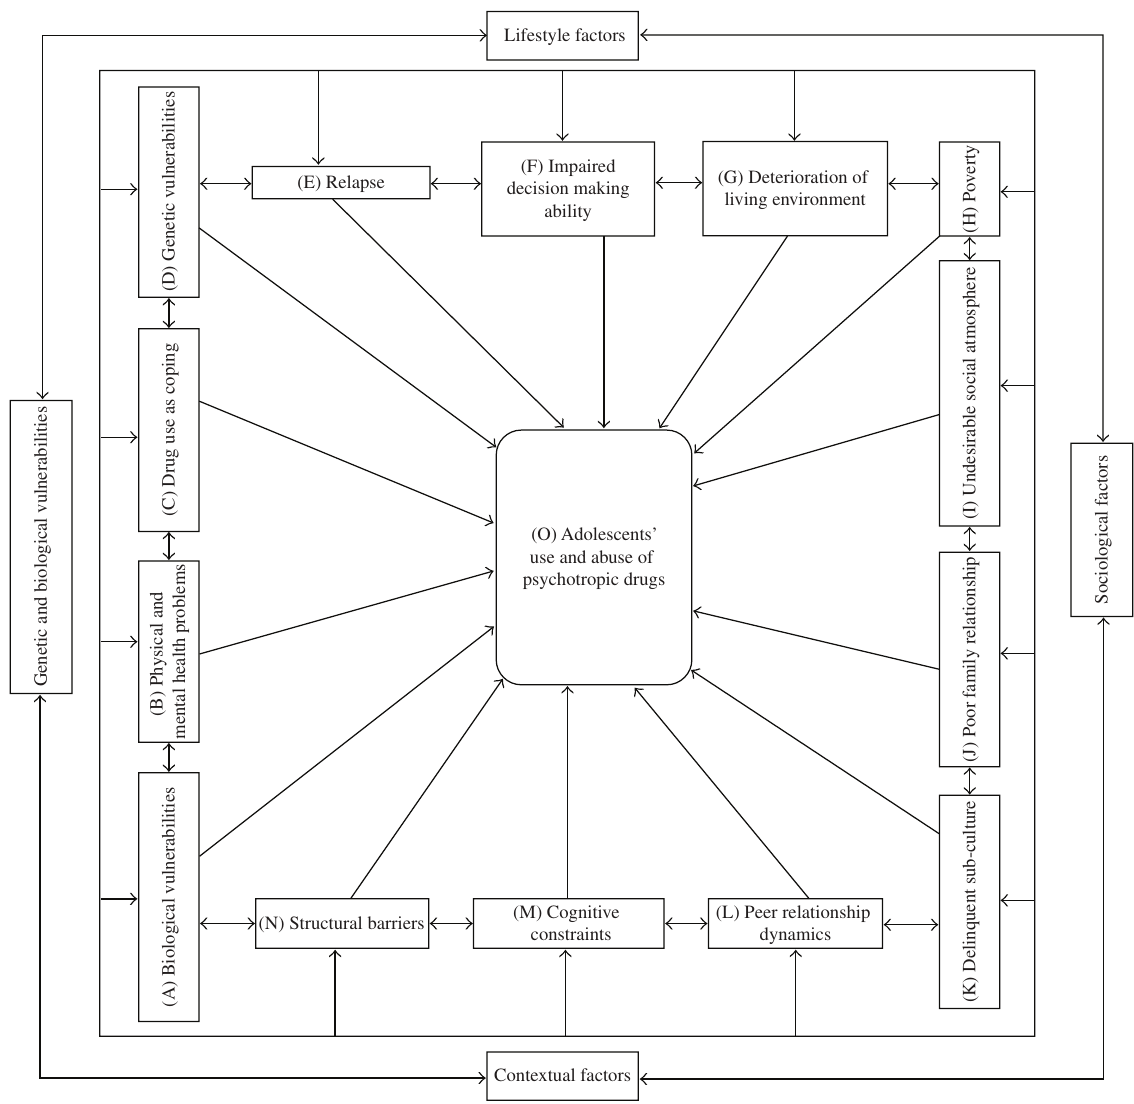
FIGURE 1: A revised model of factors contributing to adolescents’ use and abuse of psychotropic drugs.